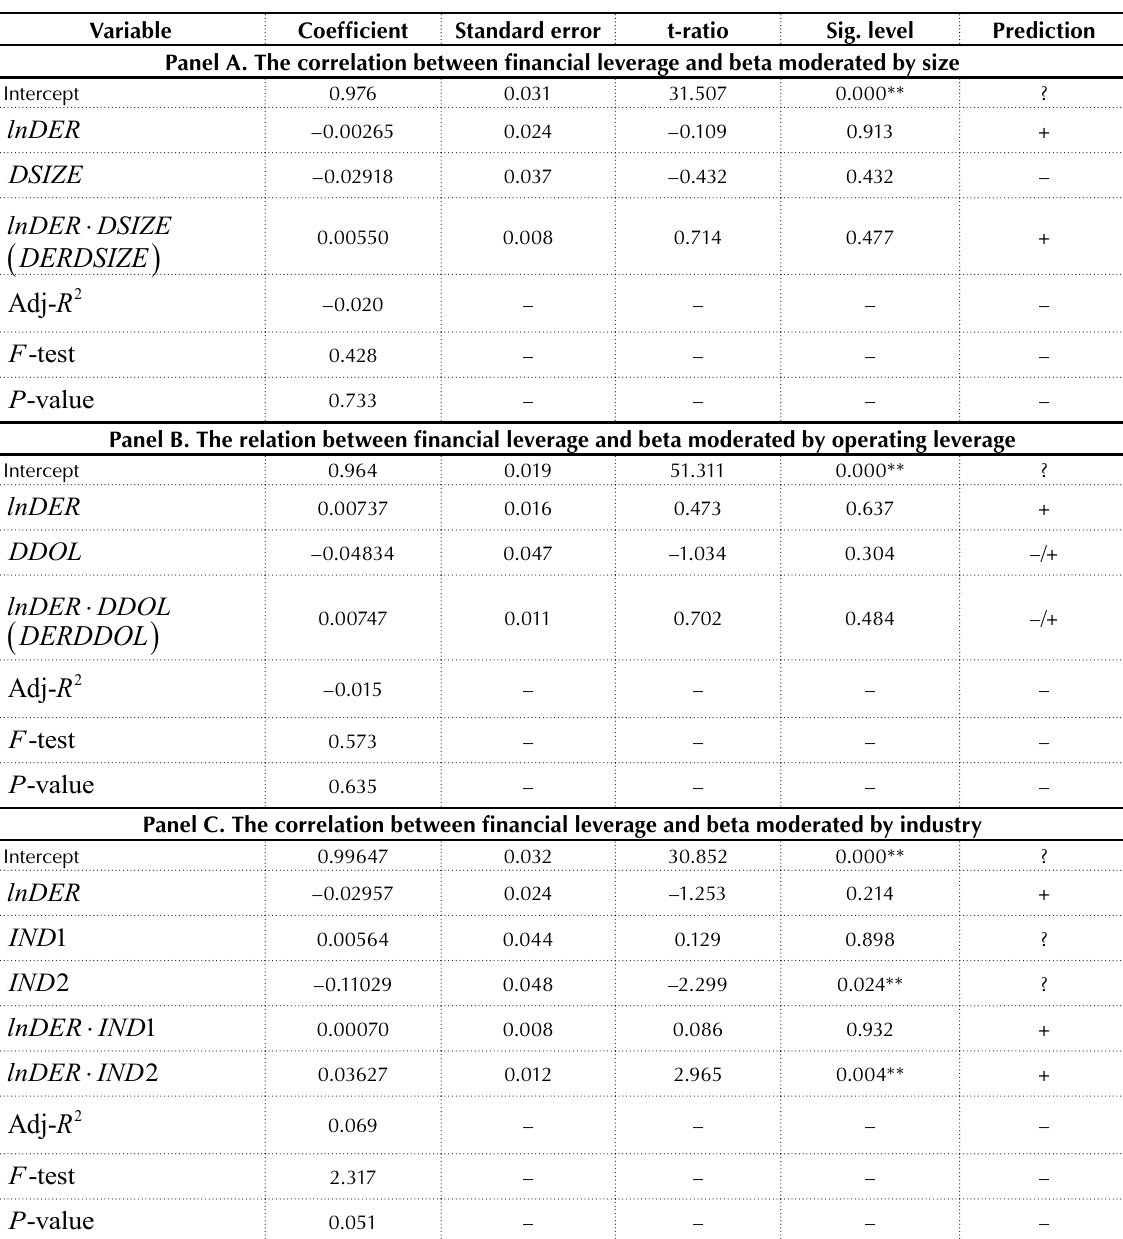
Table 2. Regression results of the relation between financial leverage and beta (panel A moderated by size; panel B moderated by operating leverage; and panel C moderated by industry) Variable Coefficient Panel A. The correlation between financial leverage and beta moderated by size